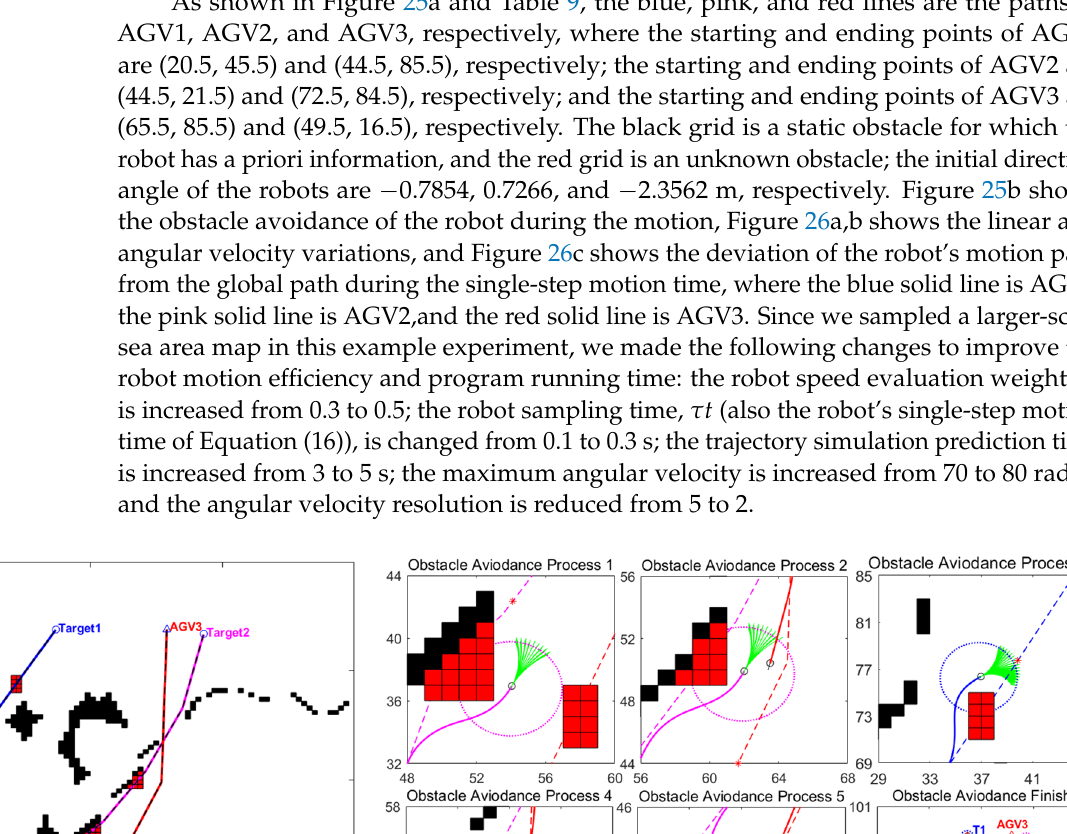
( c ) Figure 26. Multi−robot parameter comparison. ( a ) Comparison of linear velocity. ( b ) Comparison of angular velocity. ( c ) Comparison of tracking deviation. Table 9. Multi-robot path planning results in an unknown static marine environment. Indicators of the Path